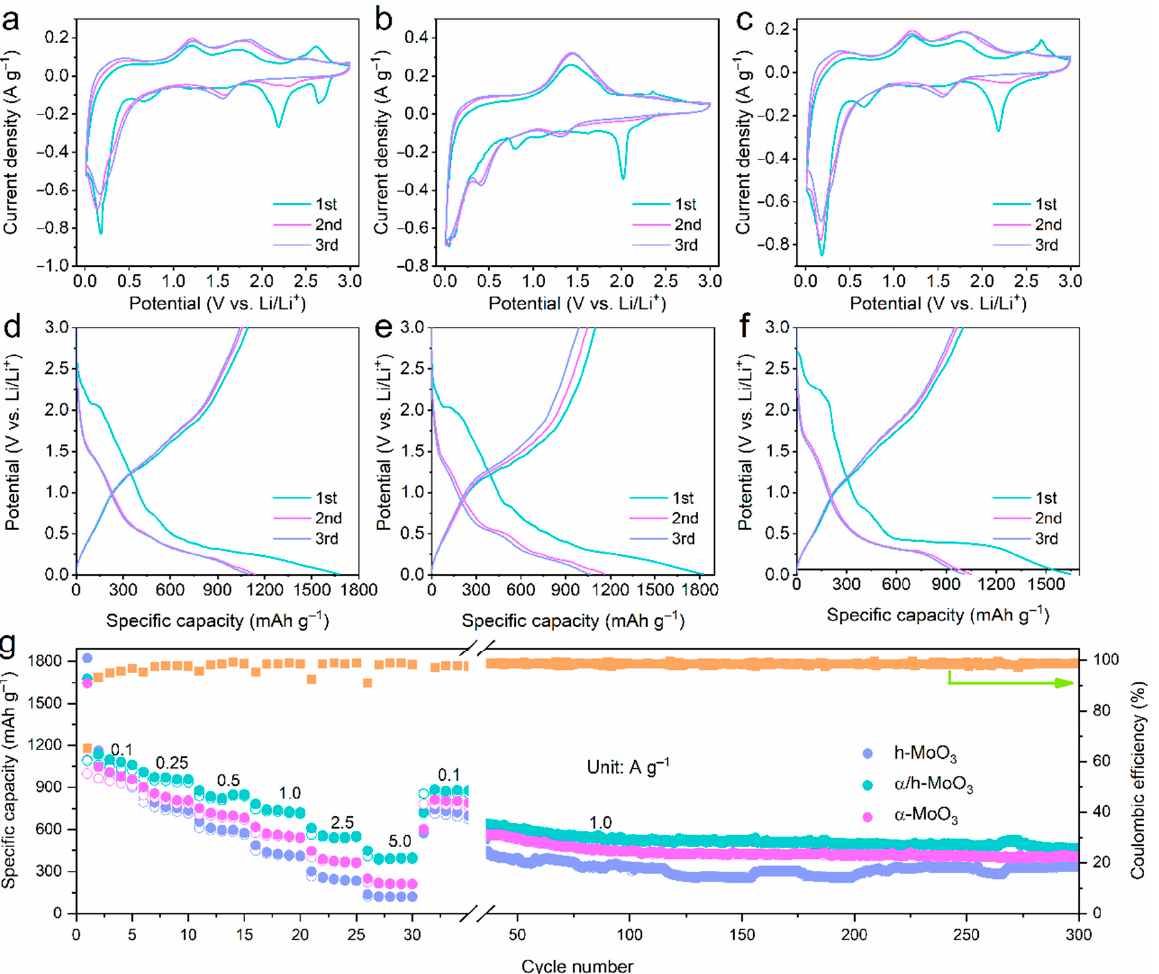
Figure 3. Electrochemical Li + storage performance of MoO 3 electrodes. The initial three CV curves at 0.1 mV s − 1 and GCD profiles at 0.1 A g − 1 of ( a , d ) Sample B: α /h-MoO 3 ; ( b , e ) Sample A: h-MoO 3 ; ( c , f ) Sample C: α -MoO 3 . ( g ) Rate capability and long-term cycling stability.